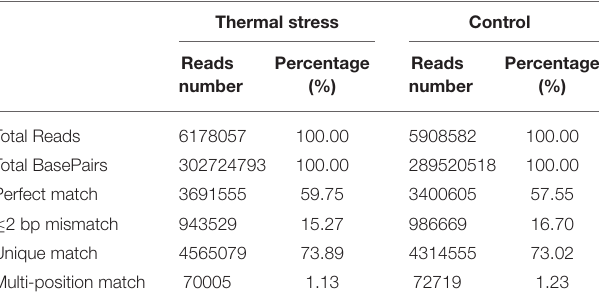
TABLE 2 | Summary of alignment statistics of DGE in two libraries mapped to reference